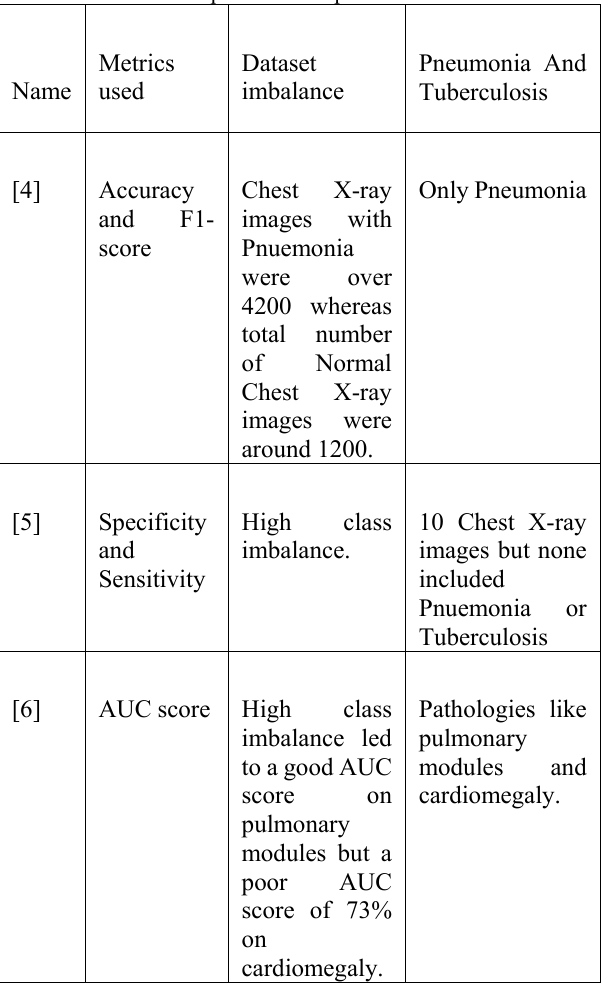
Table 1. Comparision with previous works Table 2. Confusion matrix of model trained on balanced dataset